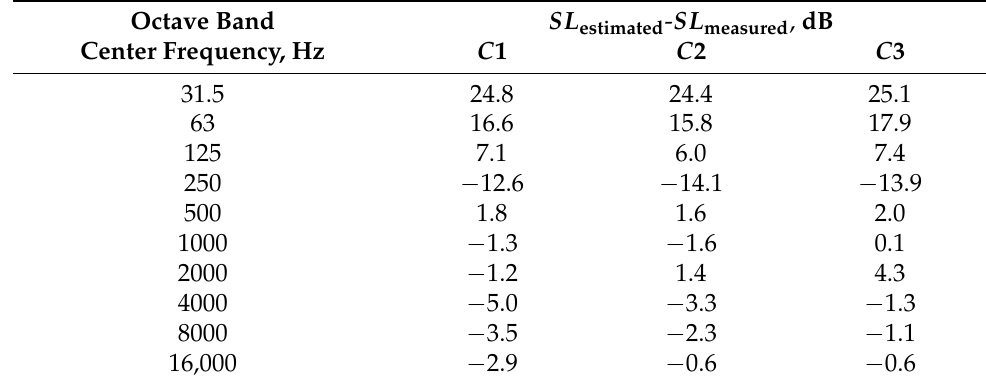
Table 4. Differences between measured and estimated source levels.